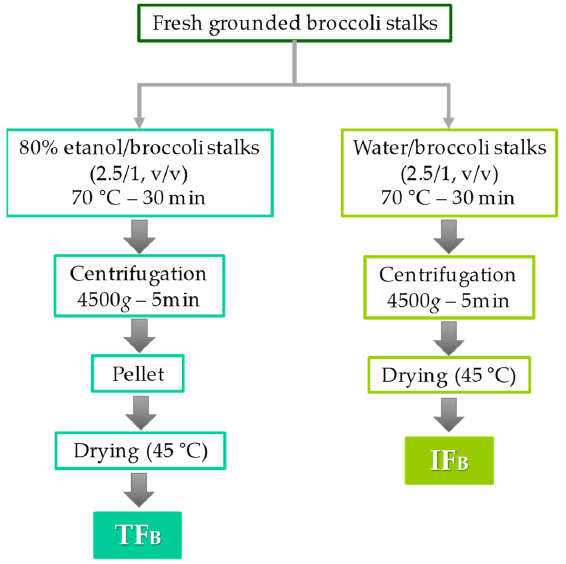
Figure 4. Flow diagram of the procedure used to obtain the fibre-rich fractions, total fibre fraction (TF B ) and insoluble fibre fraction (IF B ). (TF B ) and insoluble fibre fraction (IF B